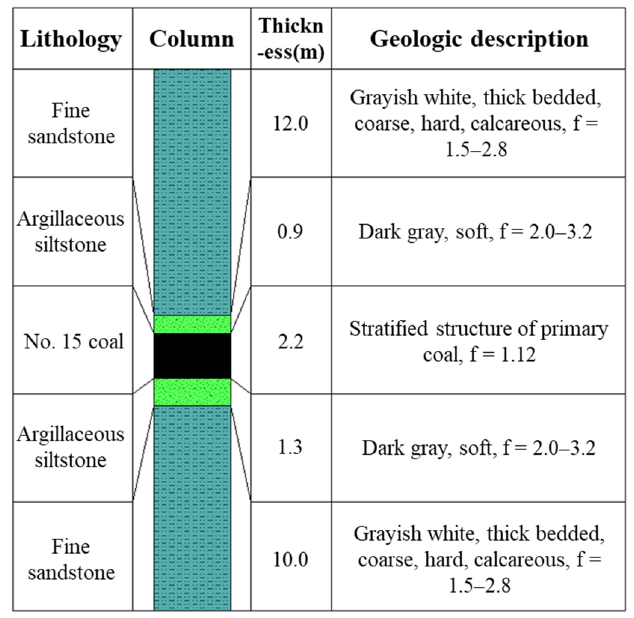
Figure 2. Strata histogram and geologic description.